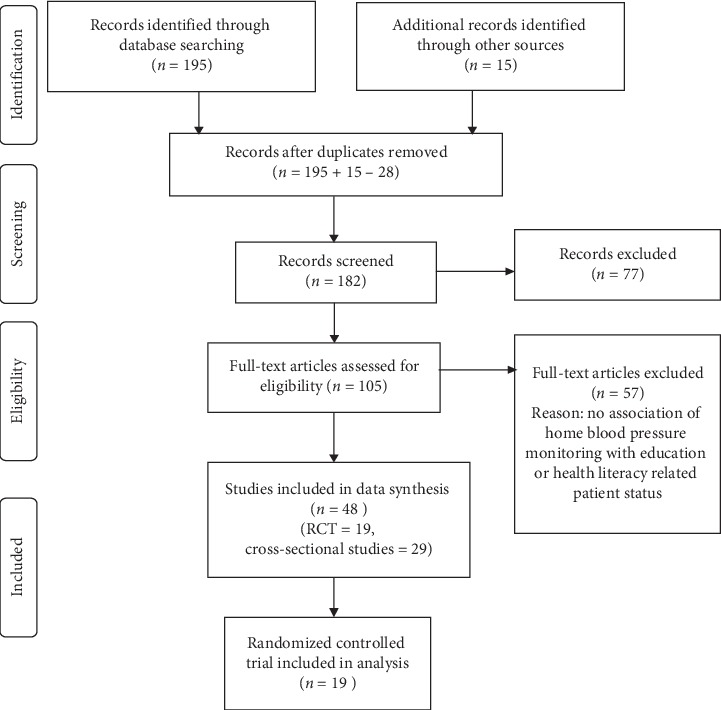
PRISMA flow diagram.